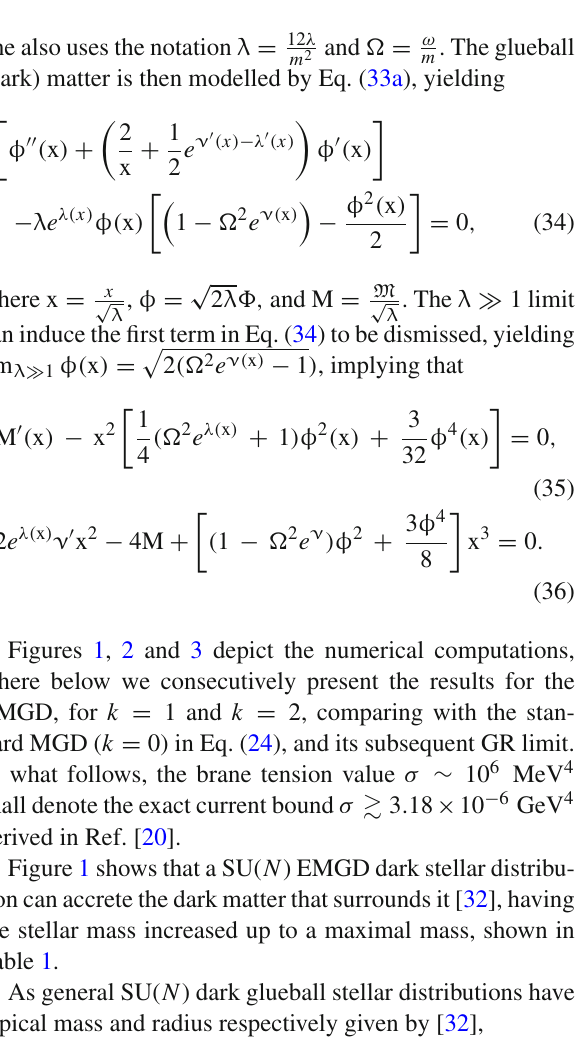
one also uses the notation λ = 12 λ